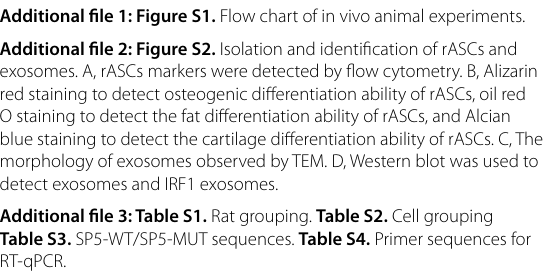
Additional file 3: Table S1. Rat grouping. Table S2. Cell grouping Table S3. SP5-WT/SP5-MUT sequences. Table S4. Primer sequences for